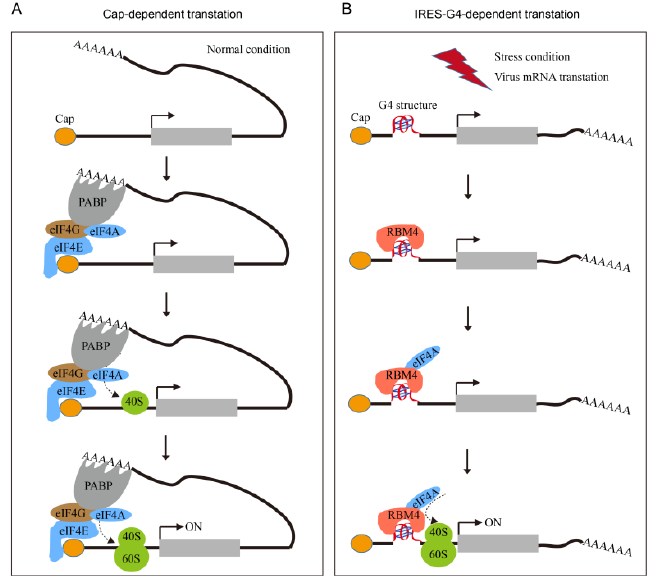
Figure 5. Diagram of proposed regulation mechanism of RBM4 and G4 structure on the translation of VEGFA . In normal conditions, VEGFA mRNA translates in a cap-dependent way ( A ). While, when cells are response to stress, VEGFA mRNA translates through IRES dependent way which needs the binding of RBM4 and G4 structure in the IRES-A element ( B ).